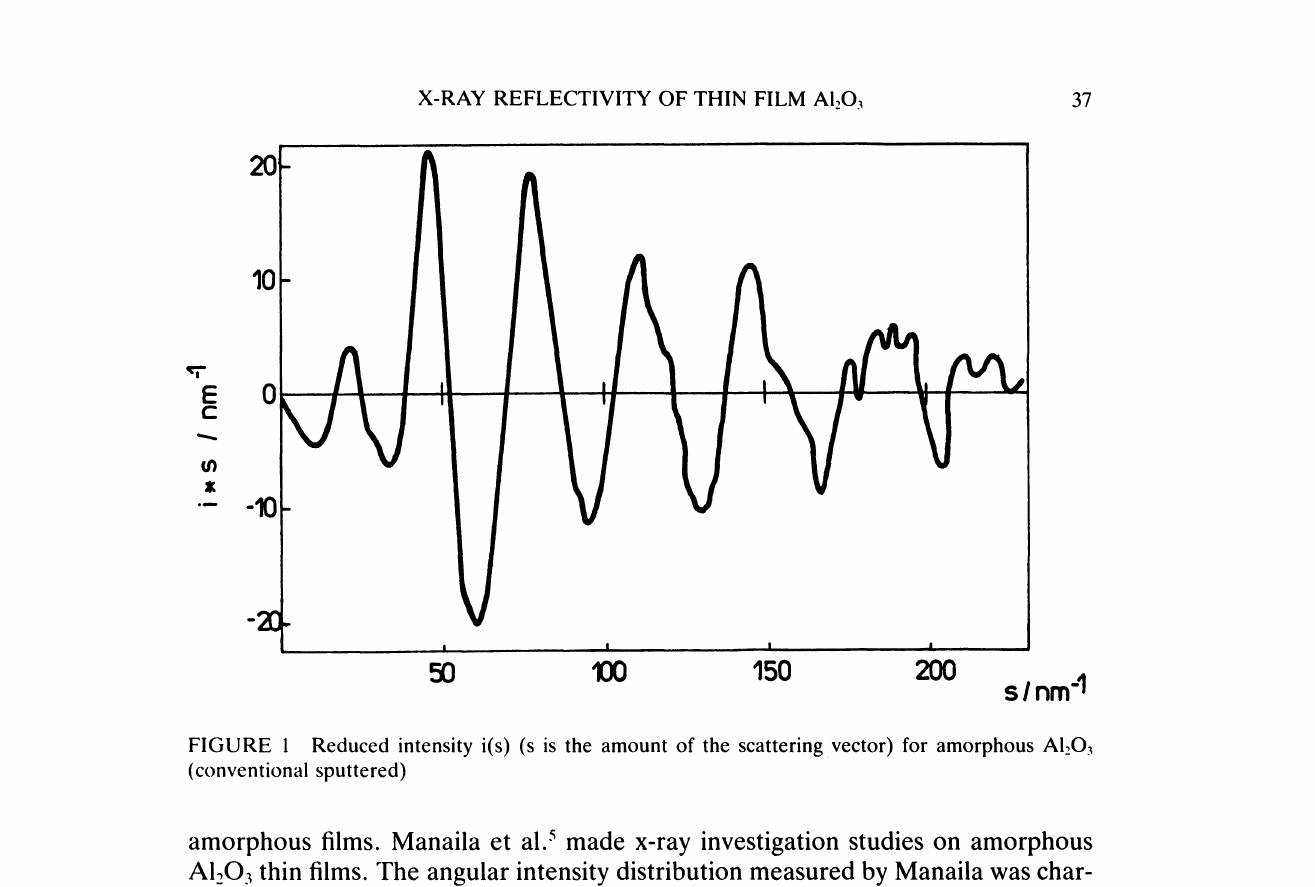
FIGURE Reduced intensity i(s) (s is the amount of the scattering vector) for amorphous AI_,O3 (conventional sputtered)